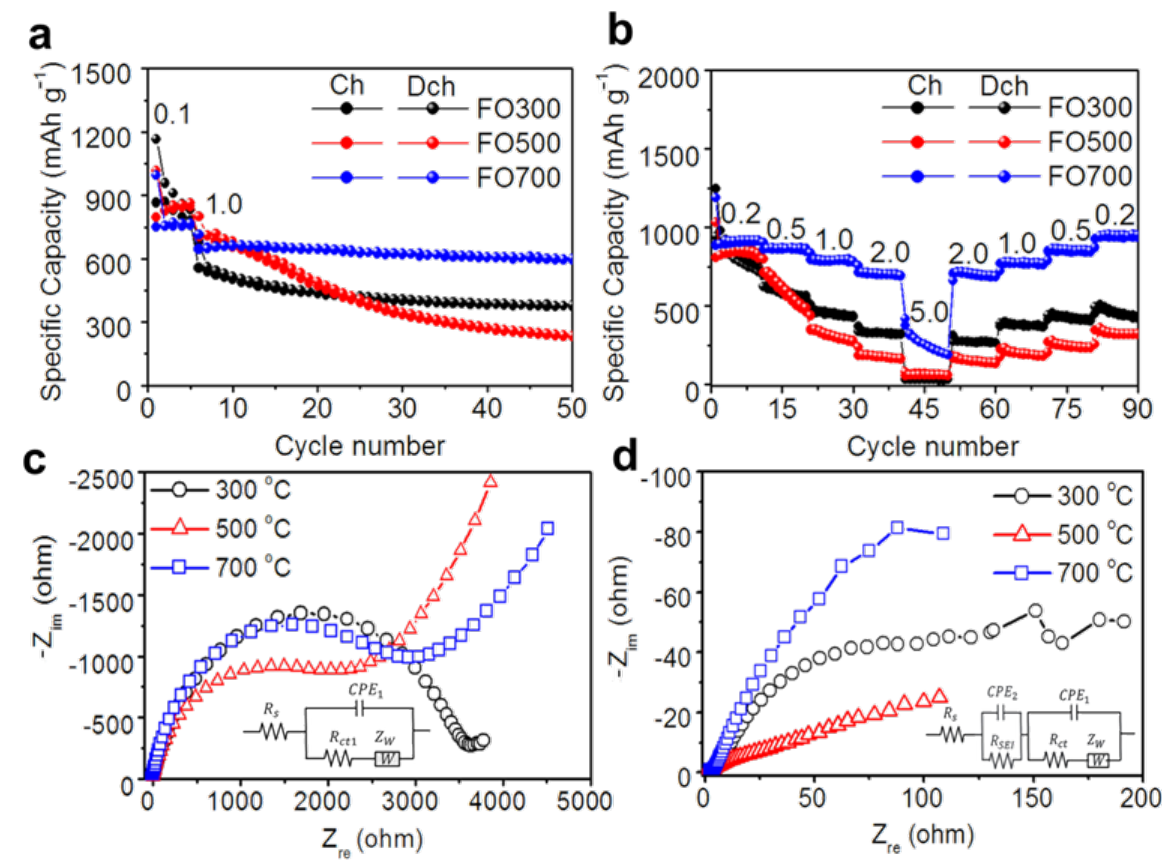
Figure 3. Electrochemical performance for the α -Fe 2 O 3 nanofibers: ( a ) the cycle stability at a current density of 1.0 A g − 1 , ( b ) the rate capability at various current densities, and the Nyquist plots of the α -Fe 2 O 3 nanofibers ( c ) before and ( d ) after cycling (the insets in Figure 3c,d show equivalent circuits used for fitting).